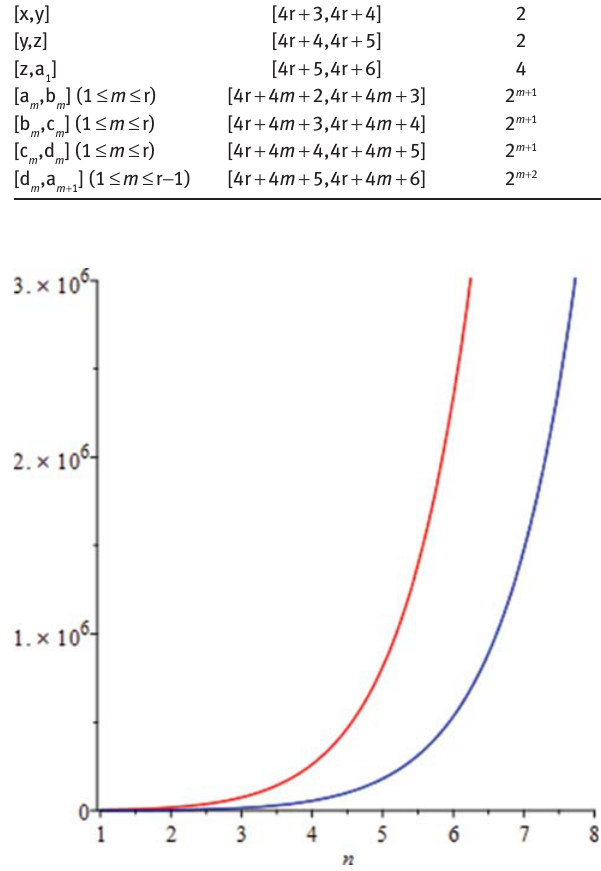
Figure 6: Comparison of first Zagreb-eccentricity index of PD [r] and second Zagreb eccentricity index of PD [r]. The colors red and blue represents the first and second Zagreb-eccentricity indices of PD [r], respectively. We can see that in the given domain M 1* ( PD [r]) is more dominating.